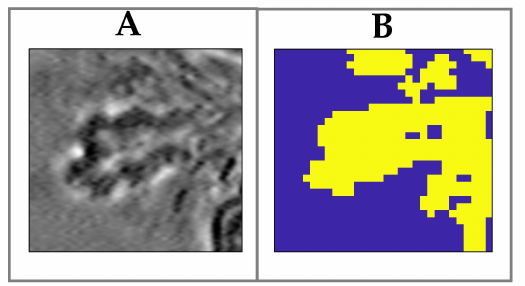
Figure 4. ( A ) Bright-field image of a ferning dentrite. ( B ) Mask used to locate the spectra corresponding only to the fern pattern (yellow region).